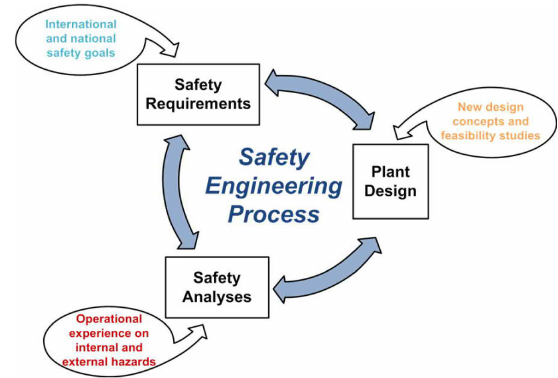
Fig. 7. Main elements of safety design and potential